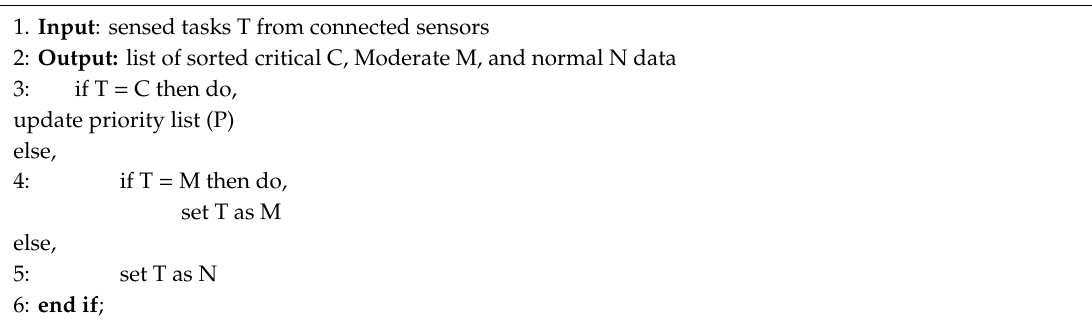
Algorithm 1: Forming a Local Task List Based on Priorities in PA